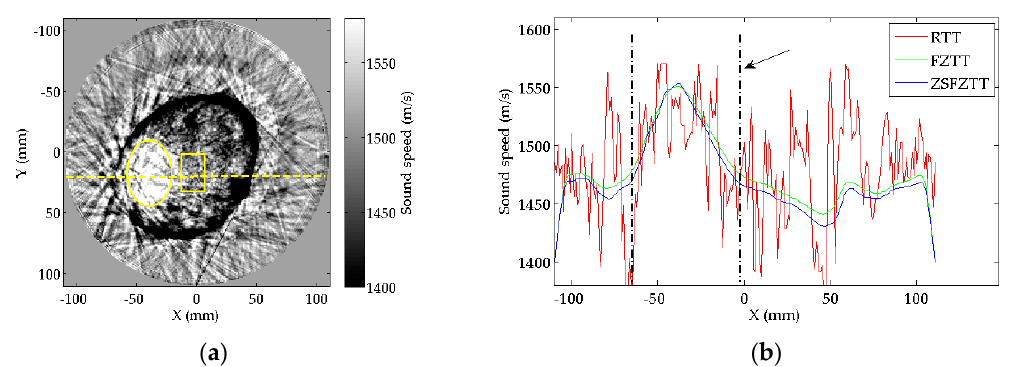
Figure 9. ( a ) The horizontal central line (the dashed line) to be measured in tumor and AOI selection (the circle and the rectangle) for measurements; ( b ) the profiles of SS value on the horizontal central line of the tumor. Table 6. The CNR measured in SS image of the patient’s breast reconstructed by the RTT, FZTT, and ZSFZTT